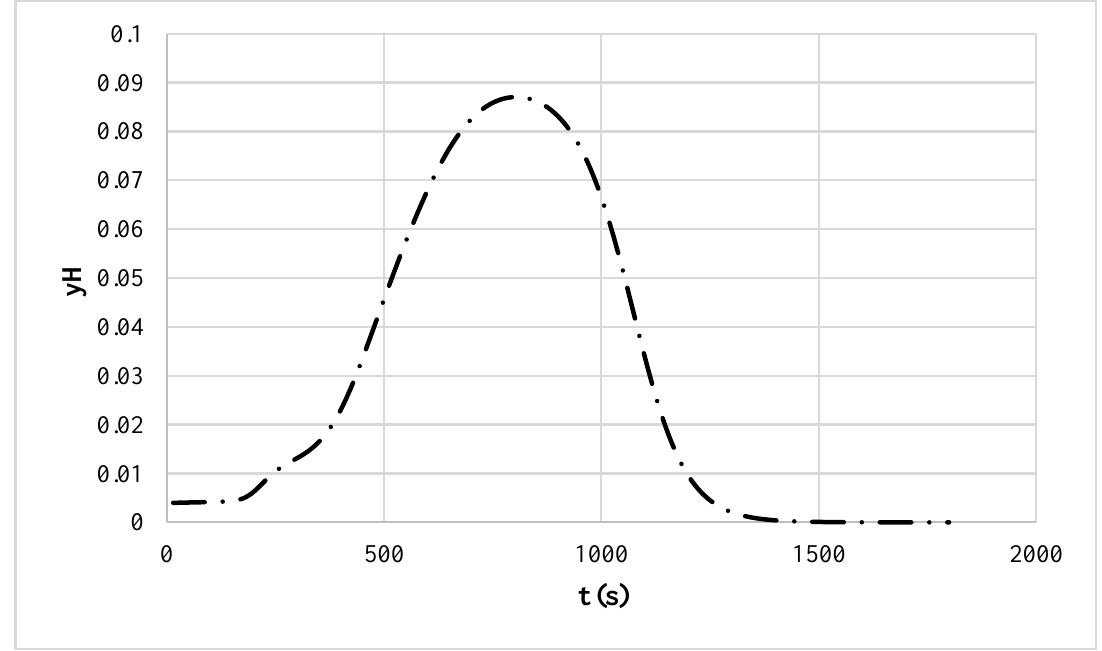
Figure 14. C6+ mole fraction in the output stream in the desorption step with time.